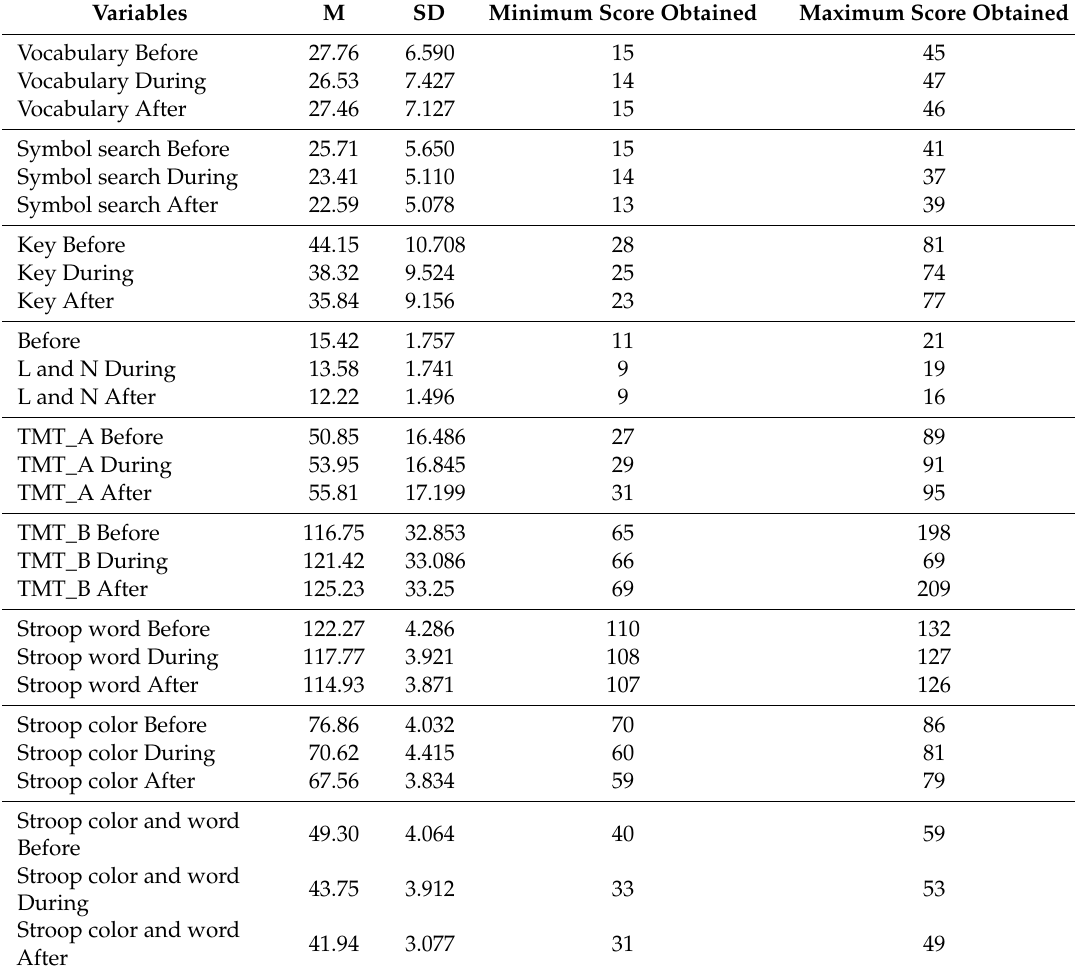
Table 2. Evolution of the domains studied in the three